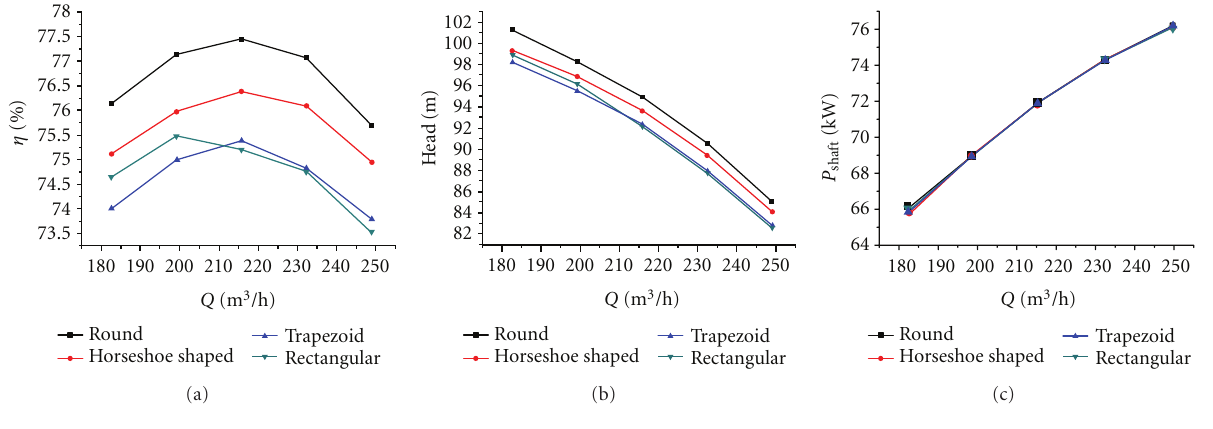
Figure 6: (a) Q - η curve, (b) Q - H curve, and (c) Q - P shaft